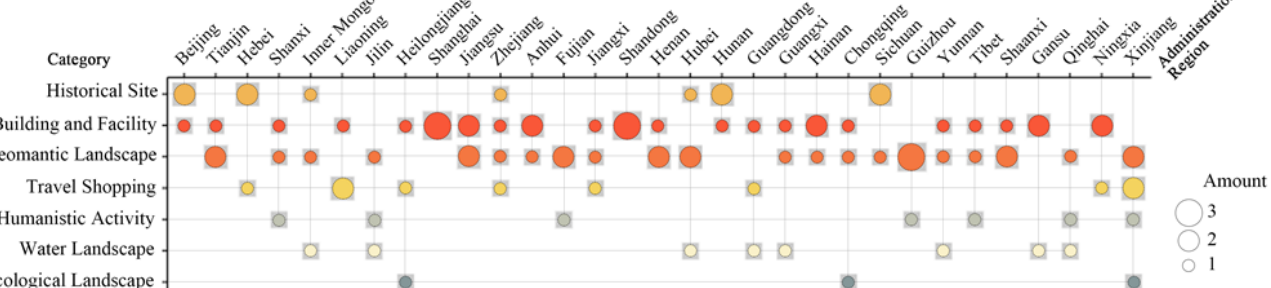
Figure 3. Regional distribution of NRTTC tourism resource categories. Table 2. Kernel density analysis of NRTTC.